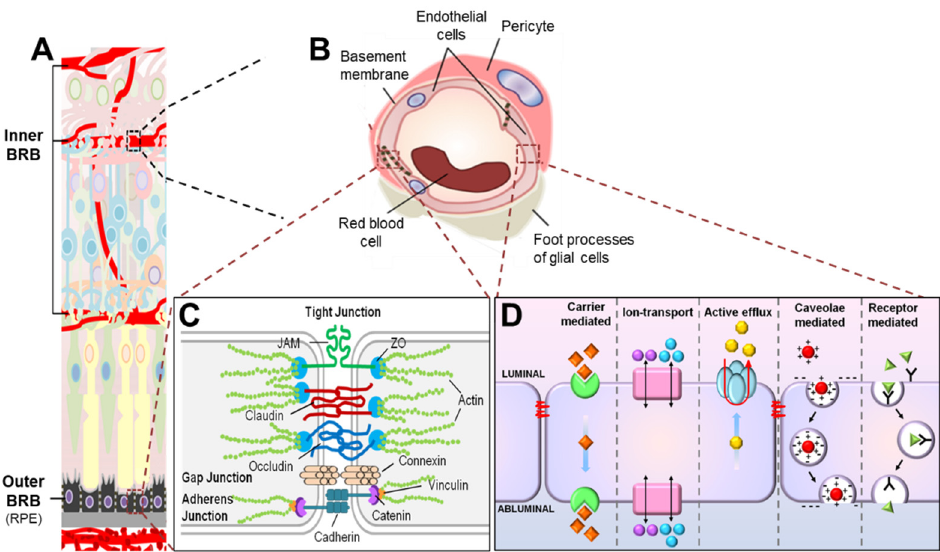
Figure 2. Scheme illustrating composition of the blood–retinal barrier (BRB). ( A ) The BRB consists of two parts, the inner BRB (iBRB) and the outer BRB (oBRB), that together regulate exchange of substances between the retina and the systemic circulation. The retinal microvasculature is the primary component of the iBRB, whereas the retinal pigment epithelium (RPE) mainly forms the oBRB. ( B ) Magnified cross-sectional view of the retinal vessel showing constituents of the iBRB. The iBRB is formed by both cellular and non-cellular components of the neurovascular unit including retinal microvascular endothelial cells (RMECs), basement membranes, pericytes, and end-foot processes of glial cells including astrocytes and Müller glia. ( C ) Transport of substances between the systemic circulation and the inner retina between RMECs (paracellular transport) is tightly regulated by junctional protein complexes including tight junctions, adherens junctions, and gap junctions. ( D ) On the other hand, substance exchange between the systemic circulation and the inner retina through RMECs (transcellular transport) is partly mediated by energy-dependent transport systems including carrier-mediated transport, ion transport, active efflux transport, caveolae-mediated transport, and receptor-mediated transport. JAM, junction adhesion molecule; ZO, zona occludens. Figure adapted with permission from Chen et al., Anti-Angiogenic Therapy in Ophthalmology , 1–19, Springer International Publishing, 2016.